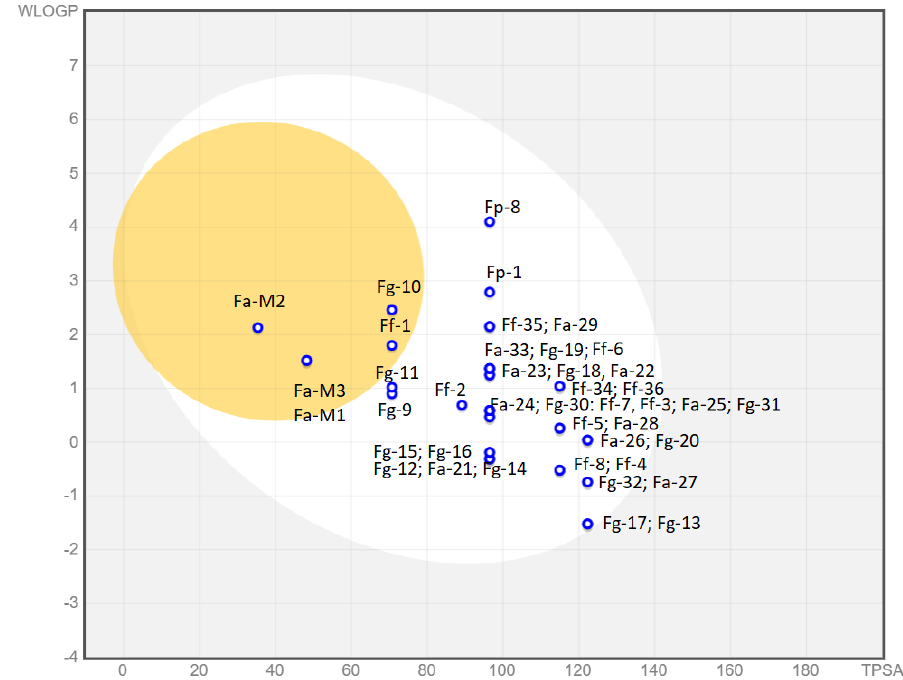
Figure 11. Boiled Egg chart. In the yolk, there are compounds probably permeable to the BBB. In the white part, there are those that could show GI absorption and in the outer part (in grey) those with low absorption and limited brain penetration. In Table 5, compounds are color-coded: red (not suitable), orange (partially suitable), and green (suitable).